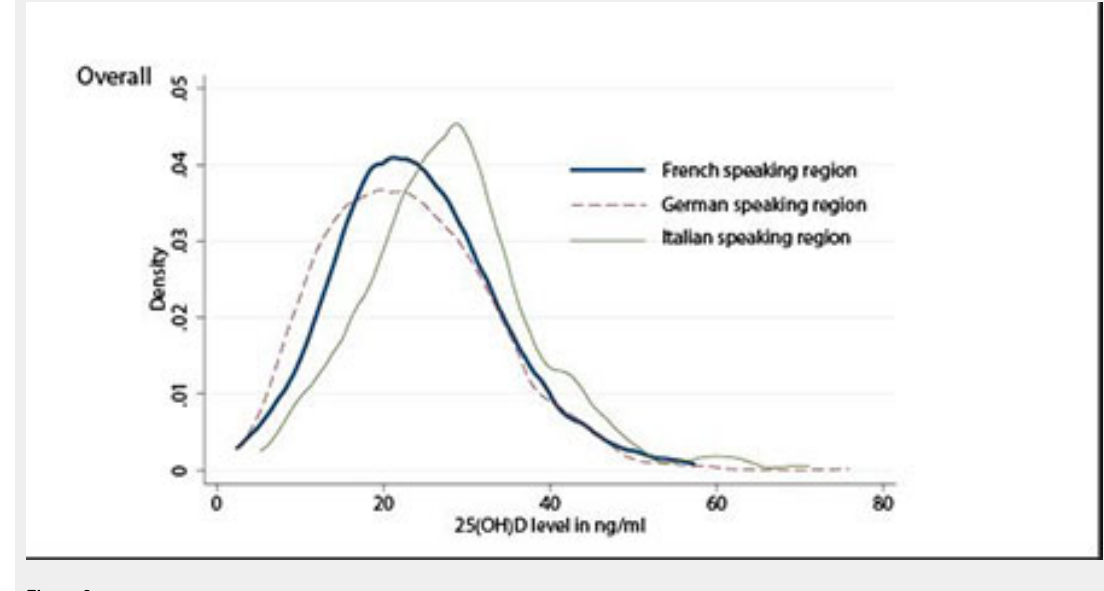
Figure 2 A 25(OH)D distribution by speaking